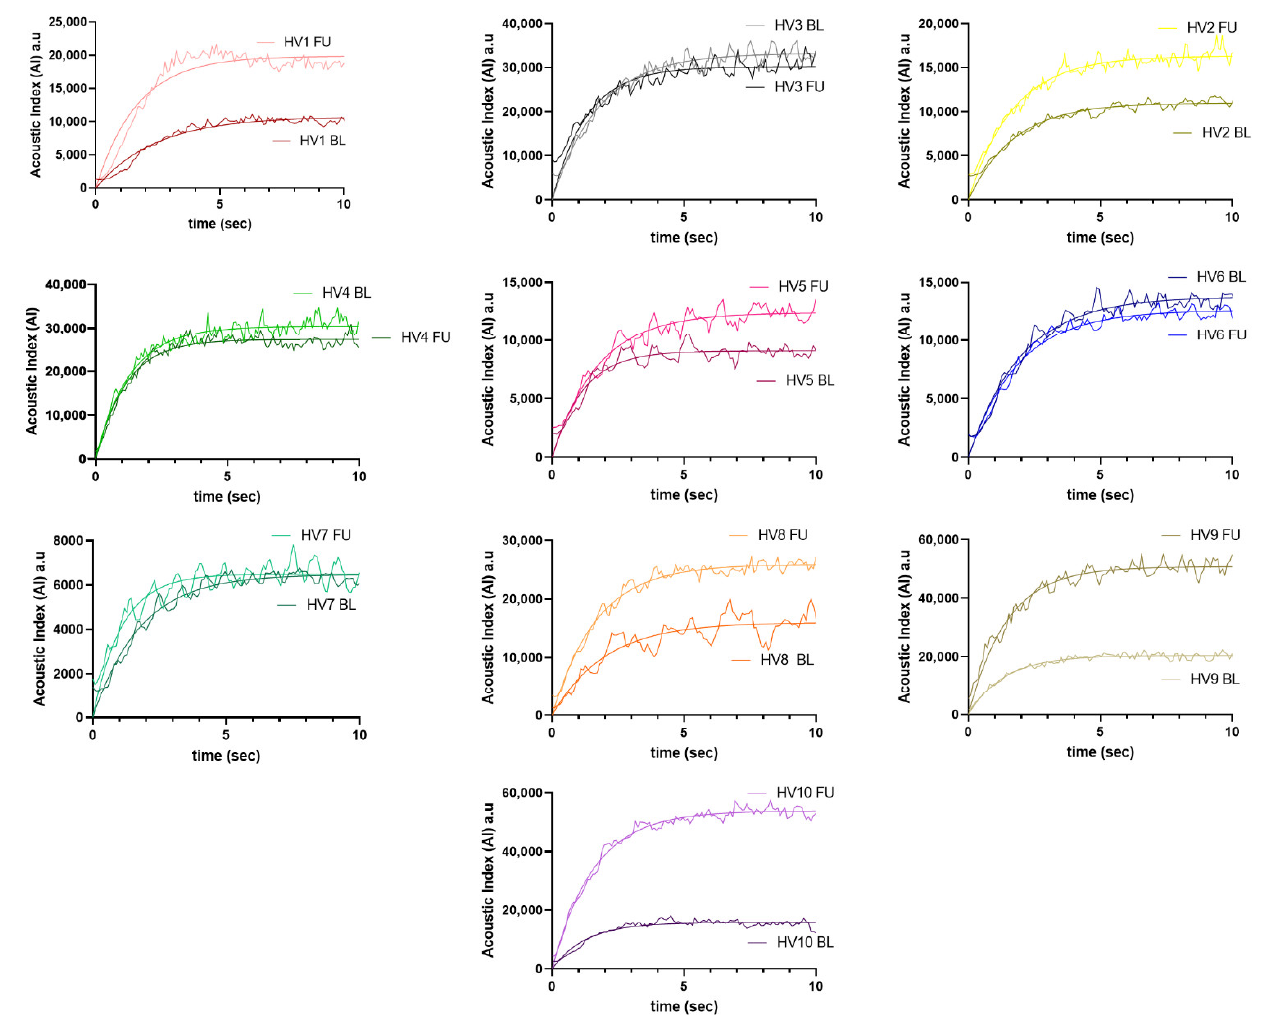
Figure 2. Time–intensity curves representing contrast replenishment in renal cortex. Table 3. Patients’ cardiovascular measures on CEUS sessions; n = 10.